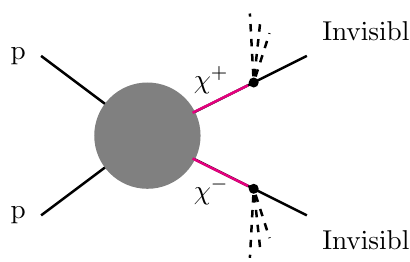
Figure 1. Production of a charged state with proper lifetime (cid:28) . 1 ns and decay products that are invisible at colliders will lead to a charged track that ends (‘disappears’) within the extent of a tracker